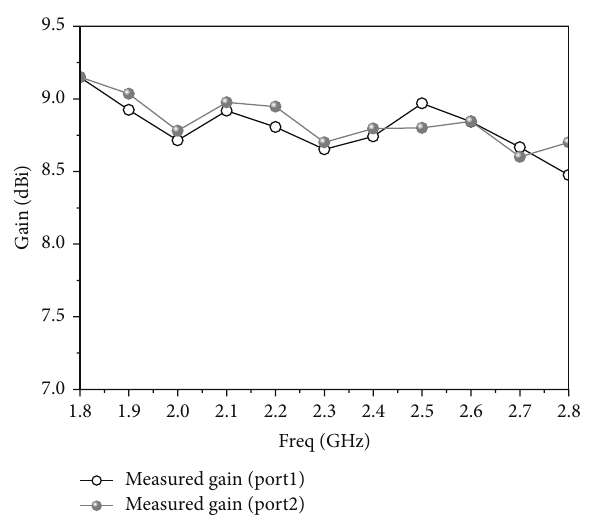
Figure 8: Measured gain of the proposed antenna. small that the radiation efficiency is close to one hundred